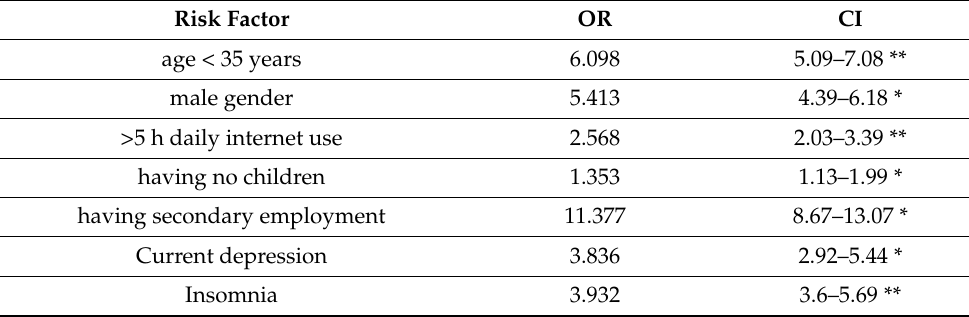
Table 3. Risk factors associated with internet addiction in a multivariate analysis. Risk Factor